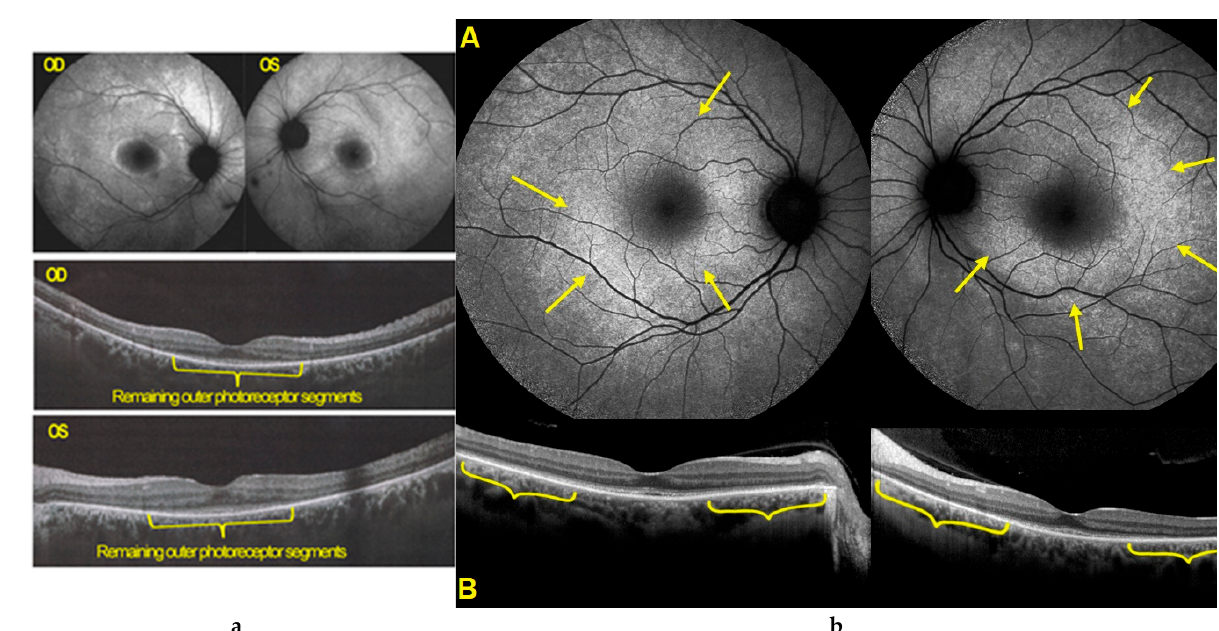
Figure 11. ( a ). BL-FAF and SD-OCT of AZOOR patient 3 at presentation. Diffuse FAF hyperautofluorescence of the posterior poles ODS due to loss of screen of photopigment present in the photoreceptor outer segments lost in the whole posterior pole except in the central foveolar area surrounded by a more hyperautofluorescent ring probably indicating centripetal progression of the process. Only a very central area of conserved outer segments can be seen ODS (yellow brackets). ( b ). BL-FAF and SD-OCT of AZOOR patient 3, 4 years earlier. Well visible annular hyperautofluorescence ( A , yellow arrows) with partial to complete loss of outer segment line ( B , yellow brackets).